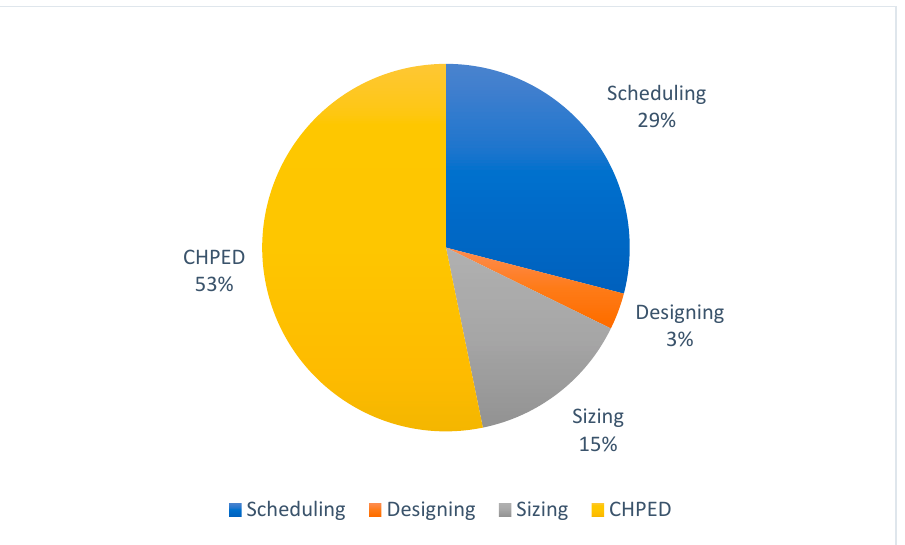
Figure 8. Sharing of the single-objective CHP optimization issues in four categories. Table 6. The numerical results of implementing different algorithms in a CHPED optimization model *. Applied